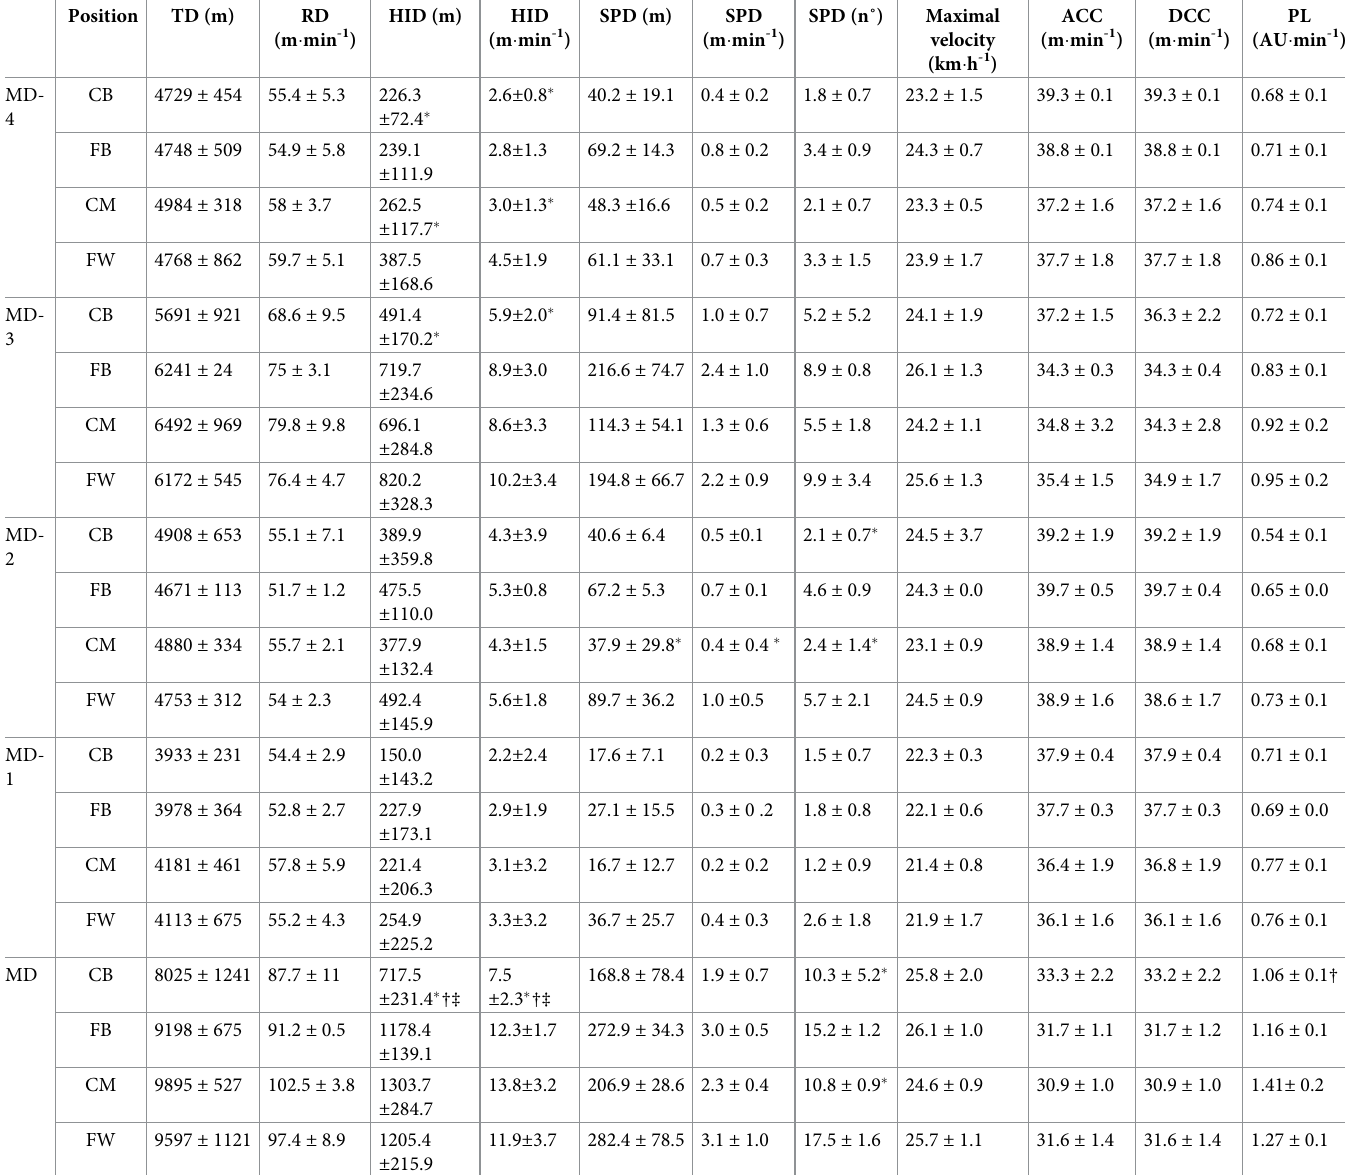
Table 4. Mean external training load variables according to days to match and playing position.